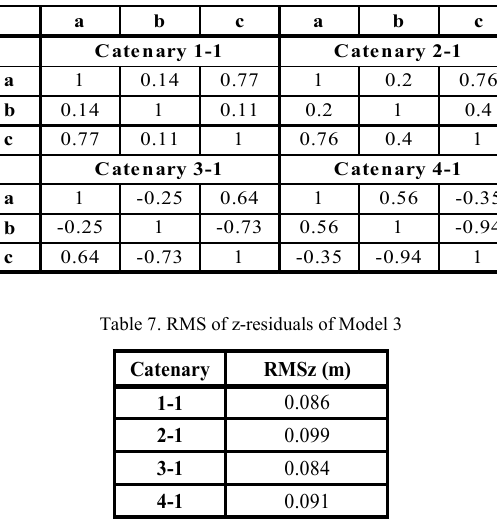
Figure 12. Residuals of the least square fitting of the real power cable point cloud using Model 3 No systematic trends are apparent in the z-residuals (Figure 12) Figure 11. Hanging power cables point cloud for testing the model from any of the four catenary fits using Model 3, regardless of asymmetry, including curve 4-1. This suggests along with the simulation results that Model 3 is indeed a valid model for 3D catenary curves. The RMS of the z-residuals (Table 7) shows that all four catenaries have been fit with a precision on the order of 8-10 cm. This magnitude might be attributed to residual systematic errors of the system assembly and also the systematic errors inherent to the scanners, but additional Table 5: Estimated parameters of Model 3 from the real power cables investigation is required to confirm this. point cloud dataset. Table 6. Correlation coefficients of Model 3 with real data